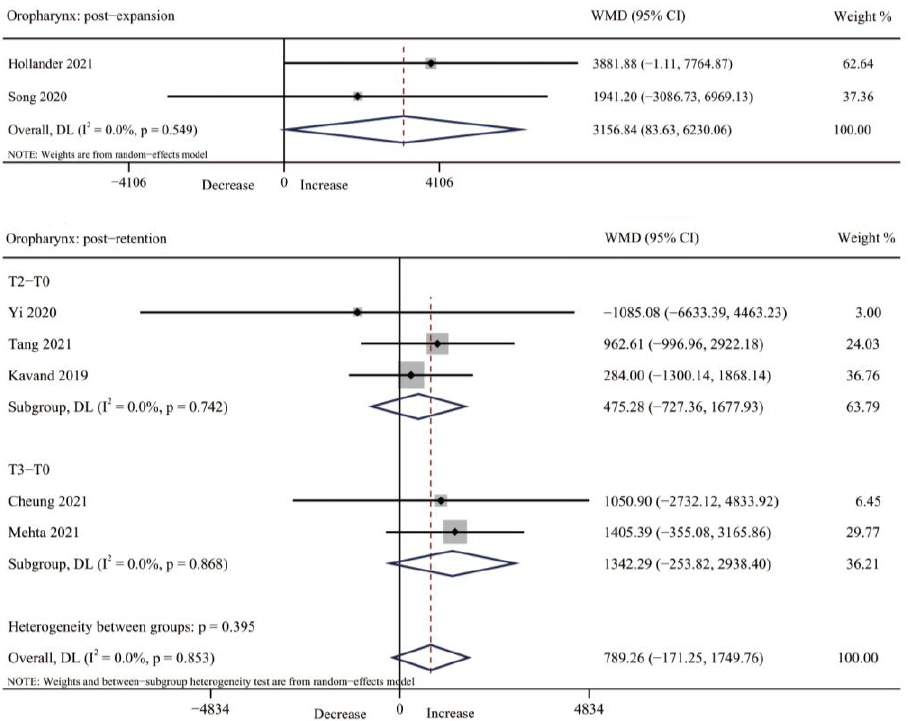
Figure 6. Forest plot for the changes of oropharynx volume immediately after expansion (T1) and retention (T2-T3). T0, before expansion; T1, immediately after expansion; T2, three months after expansion; T3, six months after expansion; WMD, weighted mean difference; CI, confidence interval [34,37–42].